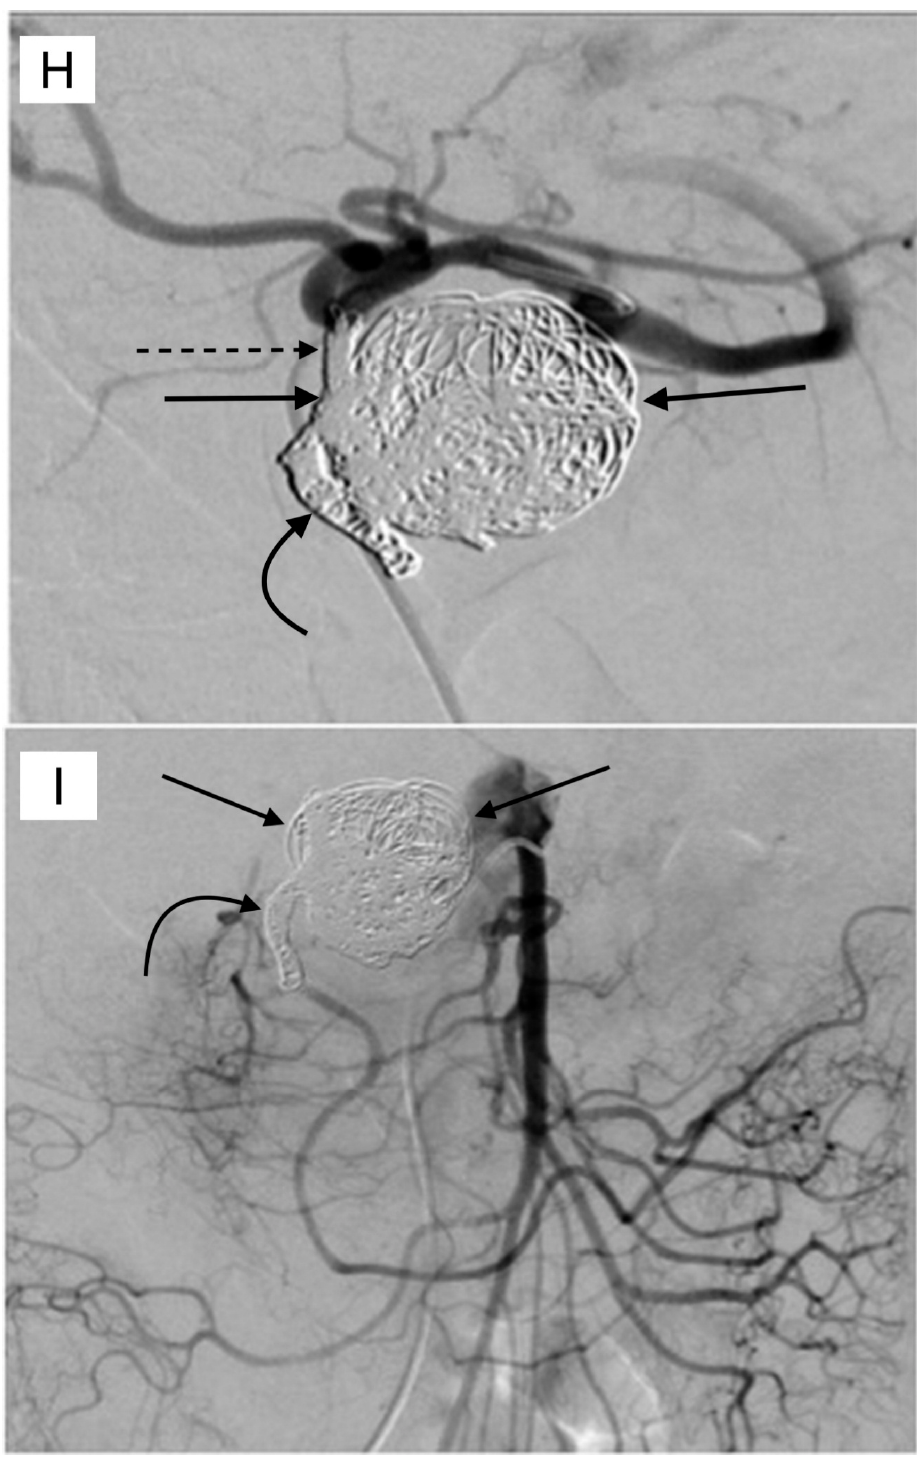
Figure 4. This 75 year old female with chronic pancreatitis secondary to pancreatic divisum who presented with worsening abdominal pain and early satiety. The ( A ) transverse abdominal ultrasound showing hypoechoic cystic structure (white star), separate from the gallbladder. The ( B ) color Doppler showed this to be highly vascular (aneurysm or pseudoaneurysm). The ( C ) T2 weighted abdominal magnetic resonance imaging (MRI) showed the mixed signal intensity within this aneurysm (white arrows). The ( D ) contrast enhanced imaging in the arterial phase showed the filling of this pseudoaneurysm